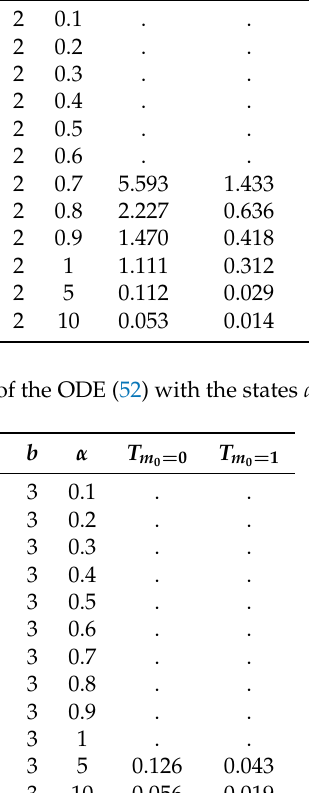
Table 4. Solvability of the ODE (52) with the states a = 0 and b = 2. a